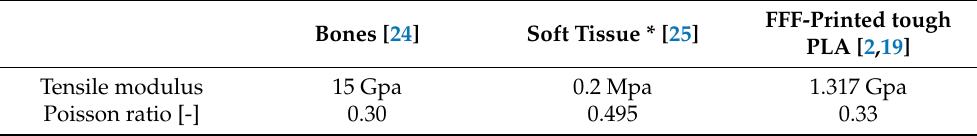
Table 1. Material properties of the model components: bones, soft tissue, and FFF-printed tough PLA perpendicular to the print direction (weakest printing